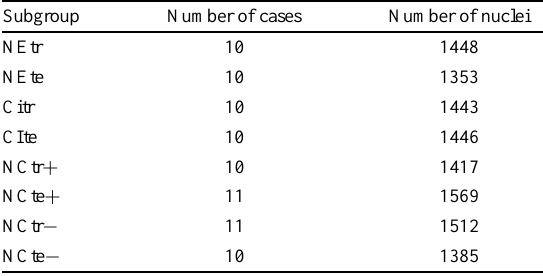
Number of cases and of nuclei per subgroup investigated